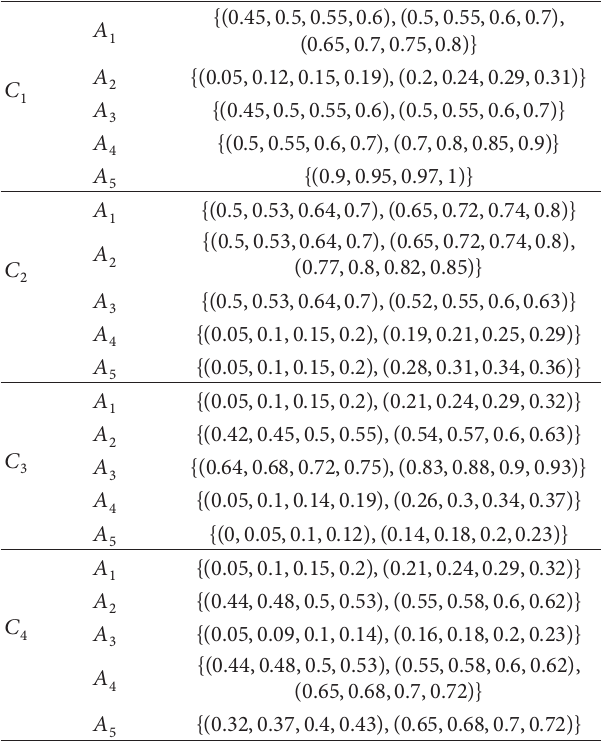
̃𝑋 1 ) with respect to decision makers 1, 2,